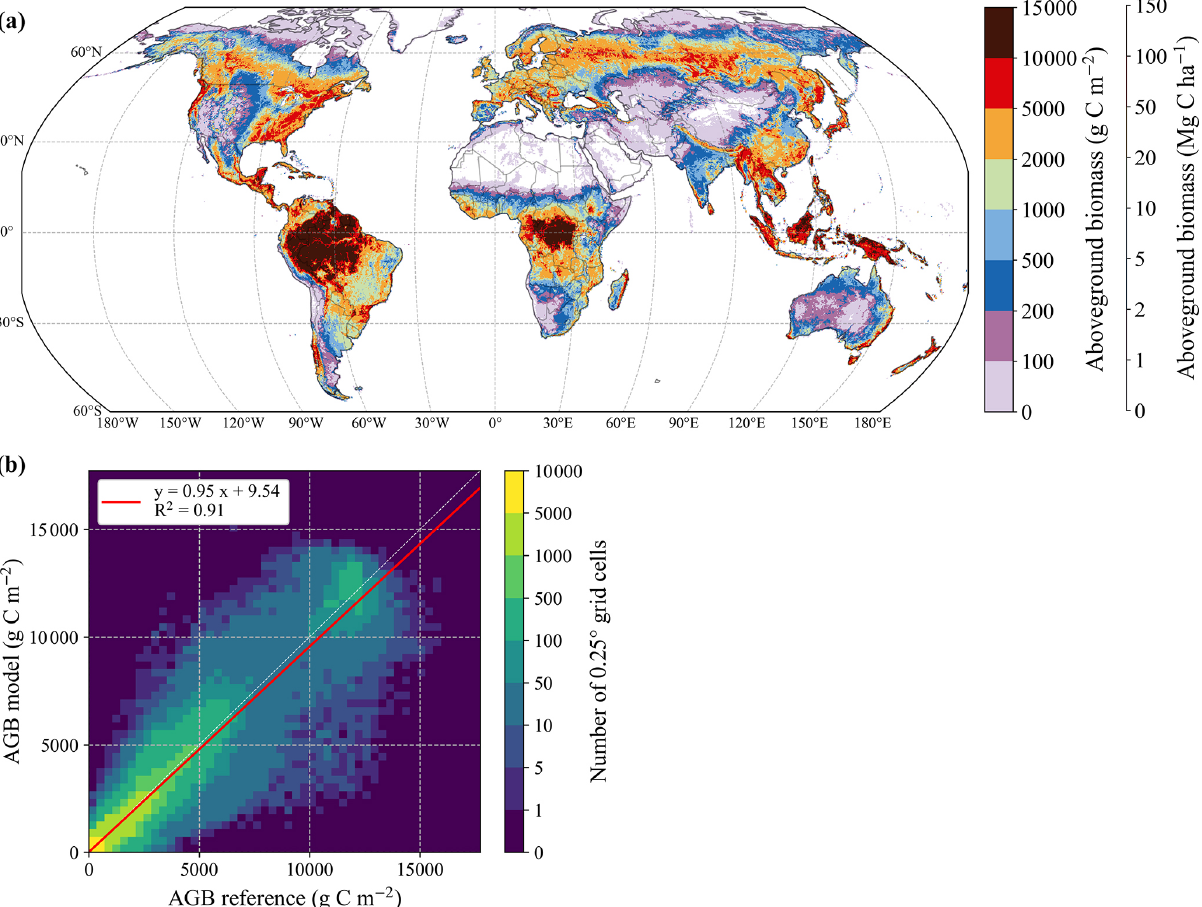
Figure 2. (a) Modelled aboveground biomass (AGB) averaged over 2002–2020 and (b) comparison of modelled versus reference above- ground biomass from Spawn et al. (2020), at an aggregated 0.25 ◦ grid cell level. Model AGB comprises the stem, leaf, and grass model pools and does not include litter pools. Panel (a) has been aggregated to 0.25 ◦ for